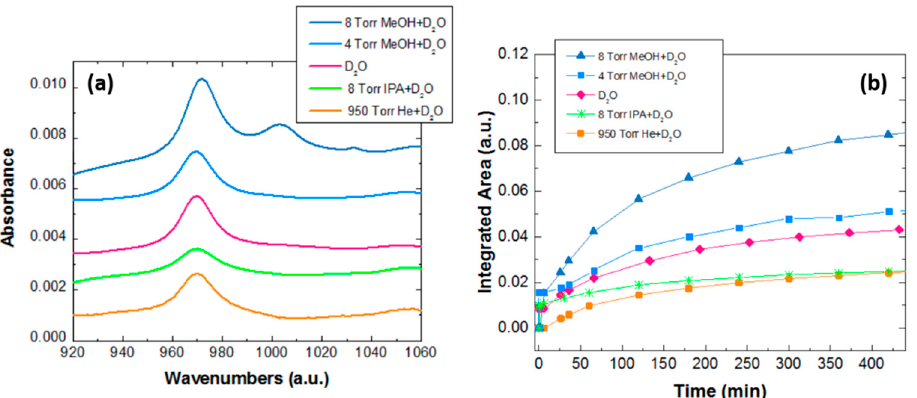
Table 1. Percentage of deuterated water dissociated after 8 h of reaction for D 2 O + guest molecules, based on data shown in Figure 1b, compared to pure D 2 O (taken as the reference, i.e., 100%).